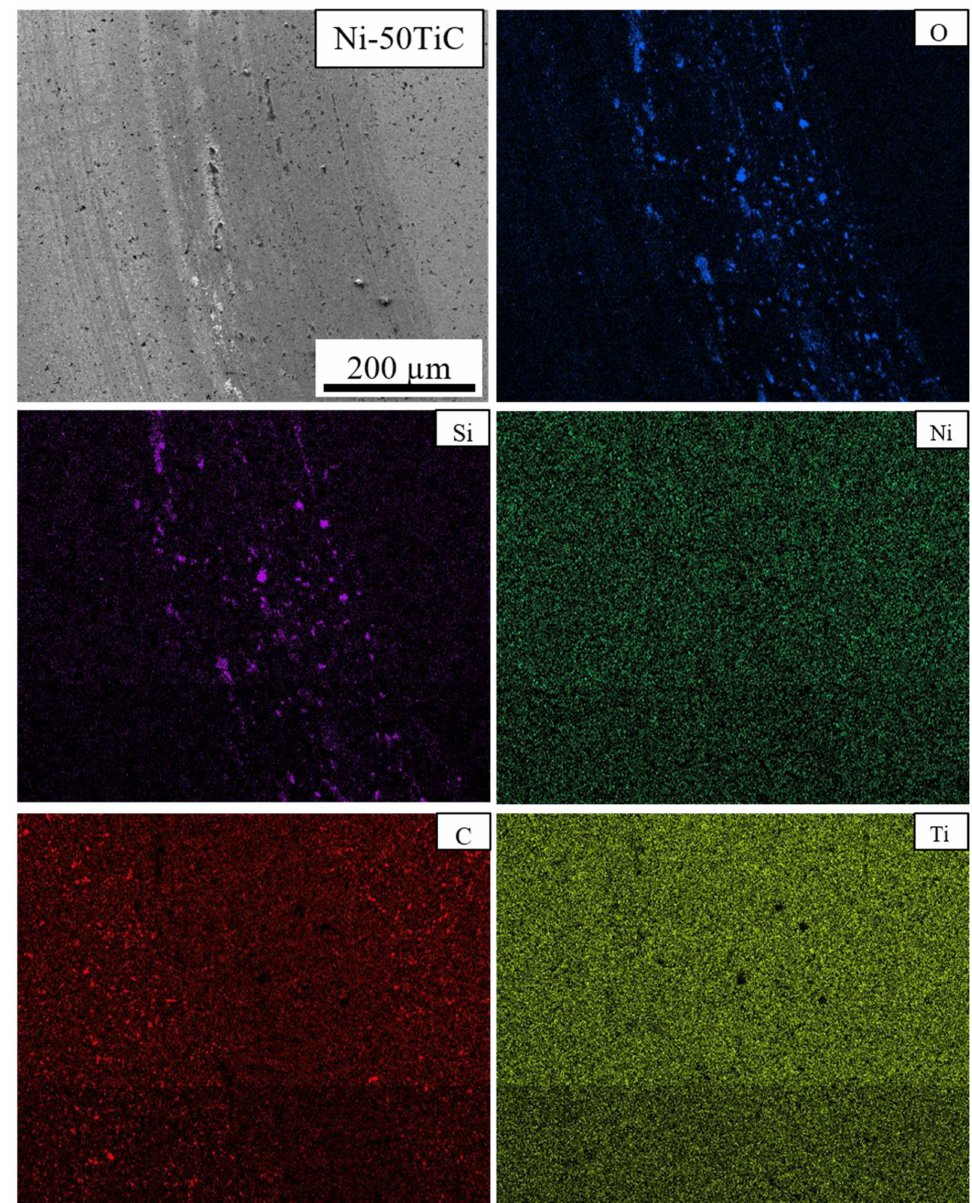
Figure 12. Wear Track EDS Map of